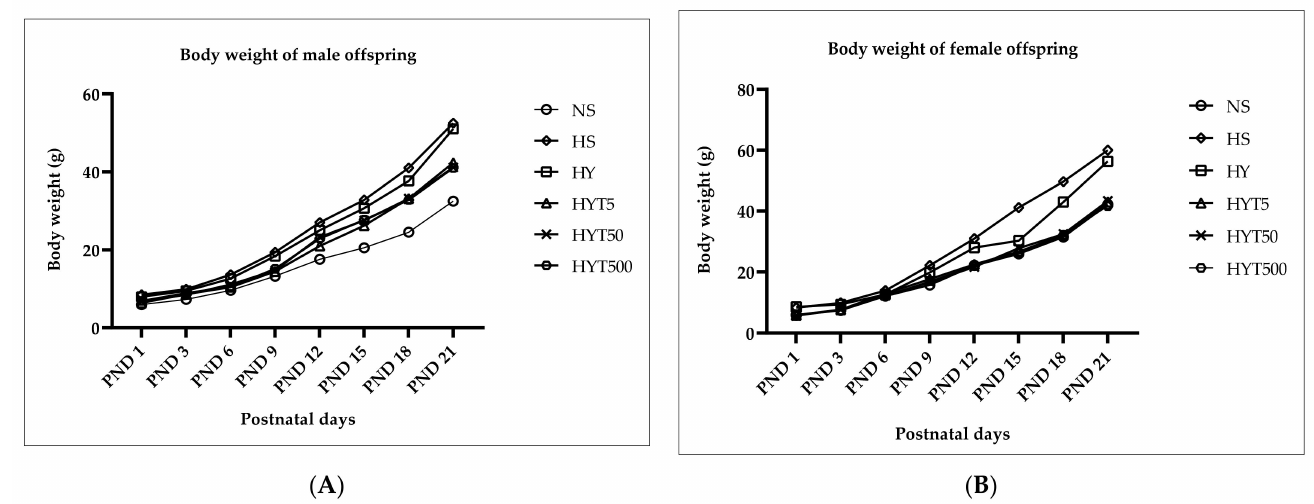
Figure 1. ( A ) The changes in body weight of male offspring from PND 1 to PND 21; ( B ) the changes in body weight of female offspring from PND 1 to PND